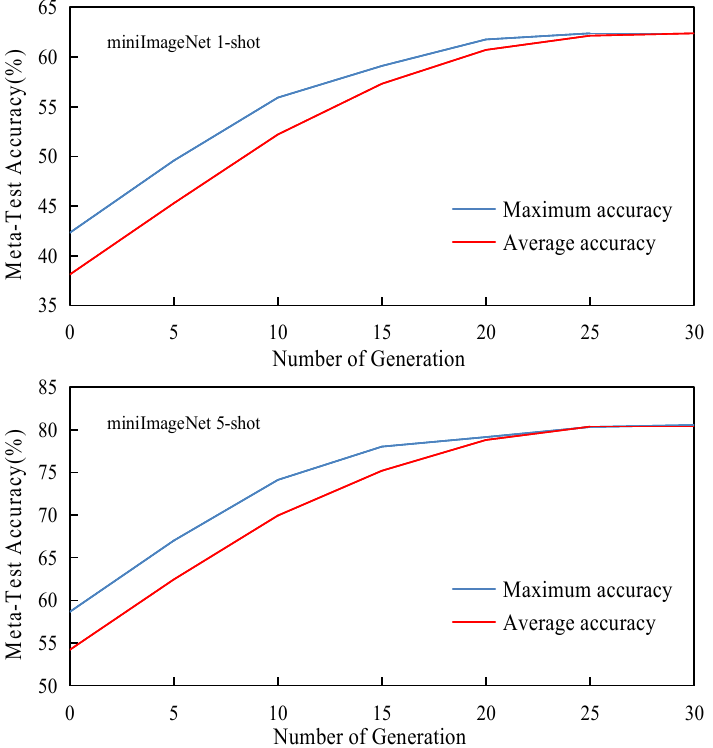
Figure 7. The relationship between the accuracy and the generation in meta-testing on miniImageNet. The 0-th generation represents the n groups of feature fusion weights randomly generated during population initialization. Table 2. Experiments were performed on CIFAR-FS and FC100 and our approach was compared with existing methods. Average meta-learning classification accuracies (%) with 95% confidence intervals on CIFAR-FS and FC100 meta-test splits. a-b-c-d denotes the size of the layer in the